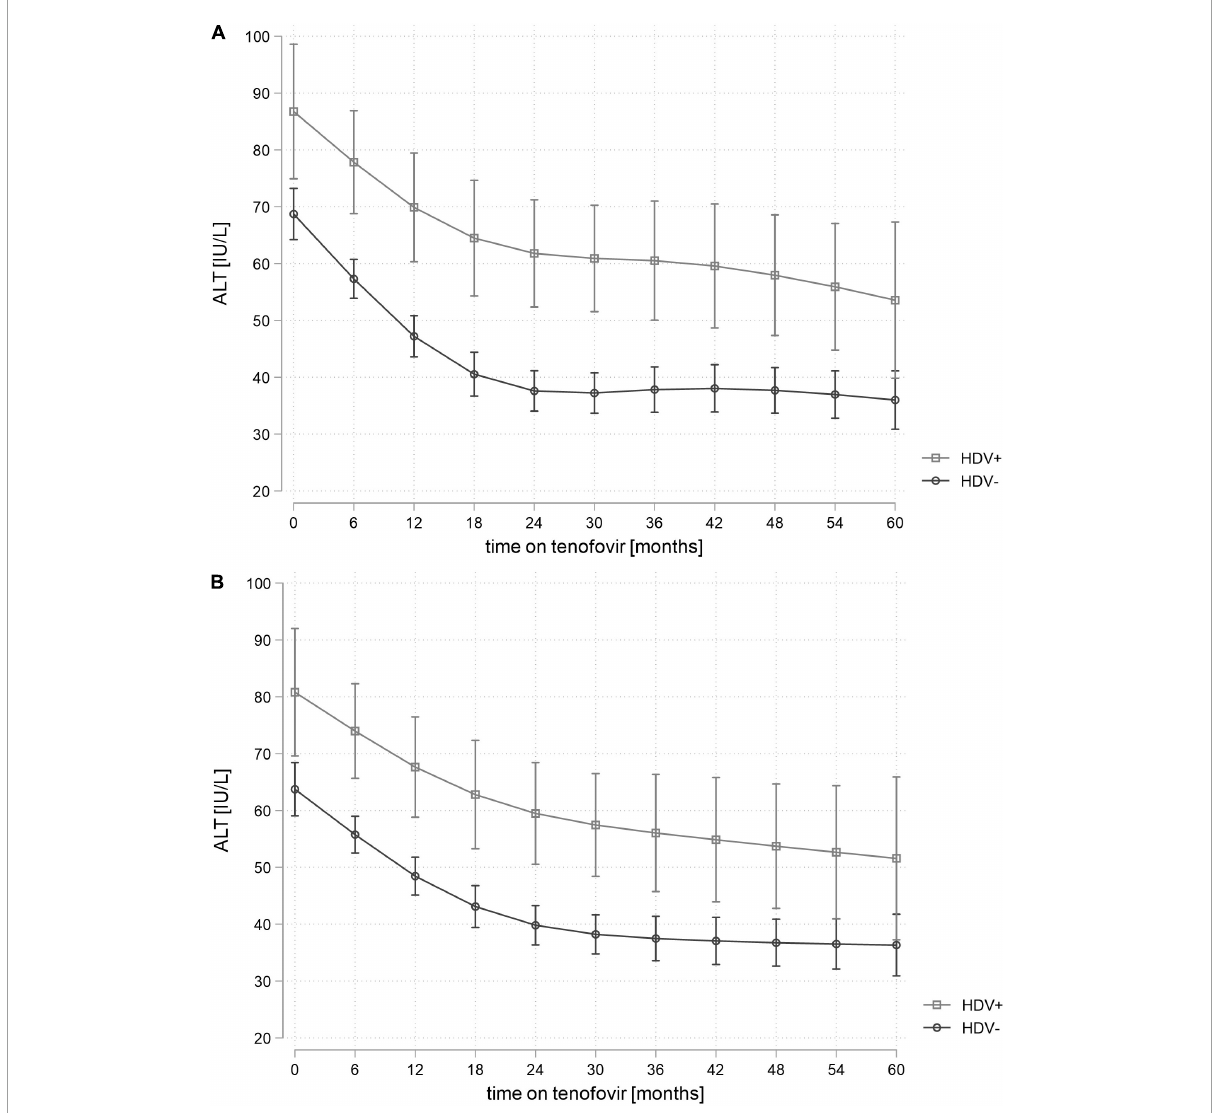
FIGURE2 Unadjusted (A) and adjusted* (B) predicted mean alanine aminotransferase (ALT) values in participants with and without hepatitis delta virus (HDV) coinfection during treatment with tenofovir. Adjusted for ALT level, age, sex, detectable hepatitis B virus (HBV) viral load, hepatitis C virus (HCV) ribonucleic acid (RNA) status and antiretroviral therapy (ART)-experience at baseline, time-updated body mass index (BMI) and treatment with tenofovir prodrugs (tenofovir disoproxil fumarate or tenofovir alafenamide). ALT, alanine aminotransferase; ART, antiretroviral therapy; BMI, body mass index; HBV, hepatitis B virus; HCV, hepatitis C virus; HDV+, anti-hepatitis delta antibodies positive; HDV-, anti-hepatitis delta antibodies negative; IU/L, international units per liter; RNA, ribonucleic